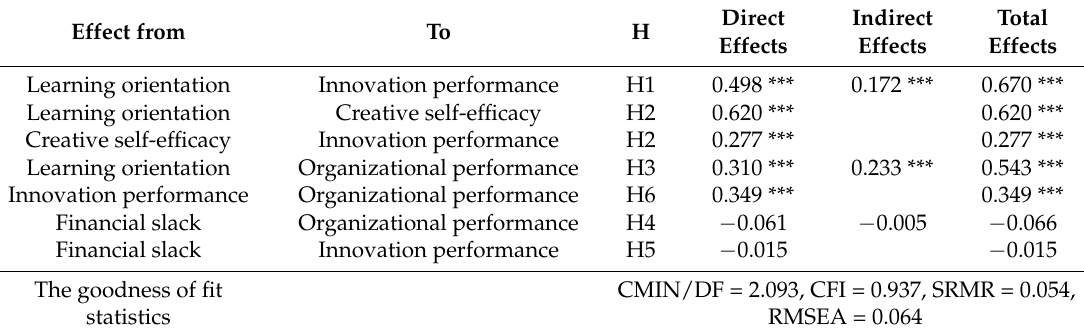
Table 6. Structural model results (direct, indirect and total effect).